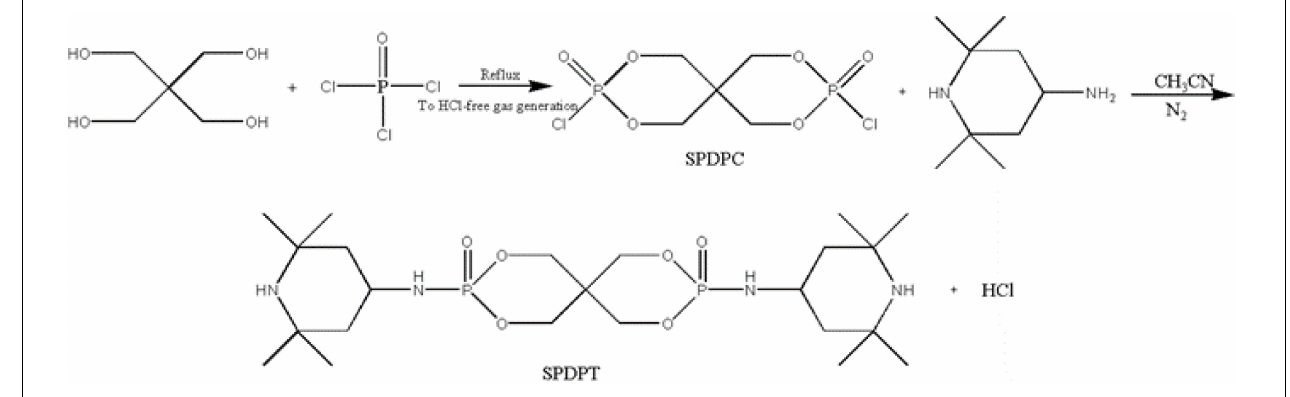
FIGURE 1 | Synthetic route of SPDPT.